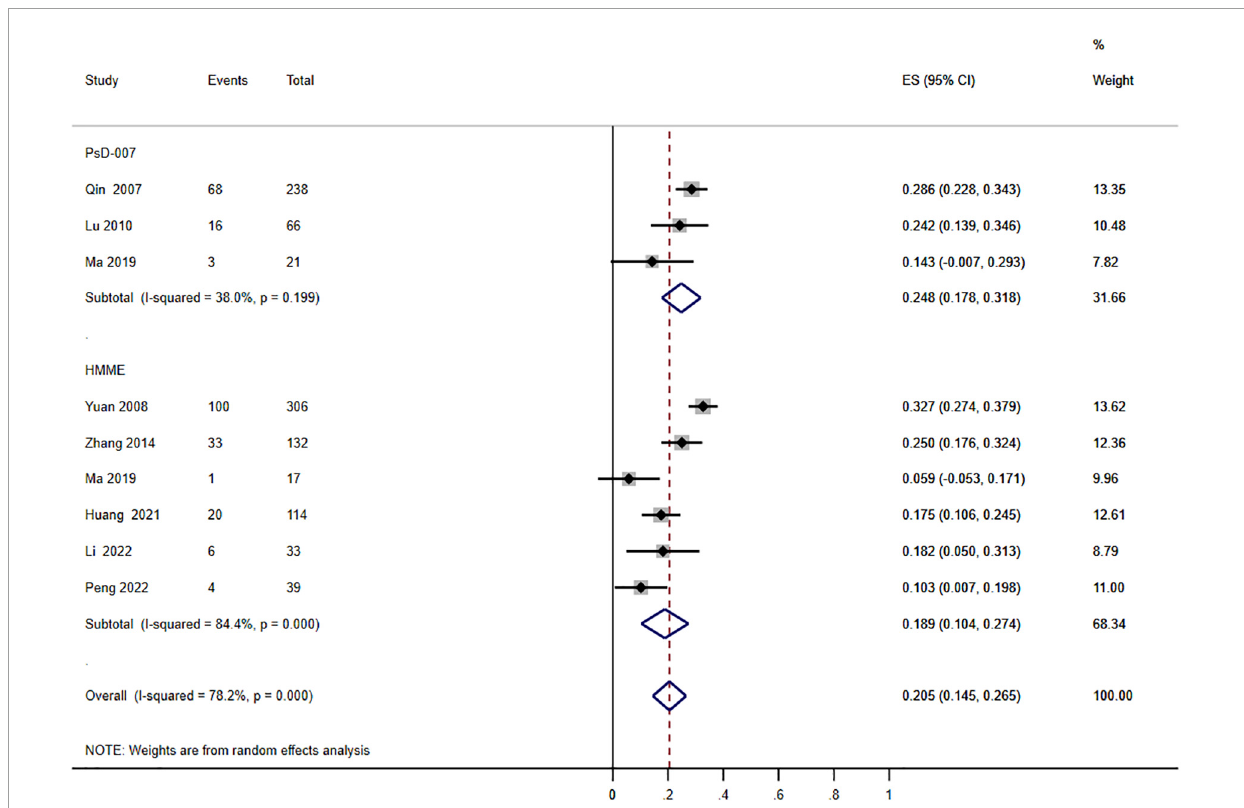
FIGURE2 Forest plot of the effects of photodynamic therapy (PDT) according to different types of photosensitizers ( ≥ 75% improvement). Weights are from random effects